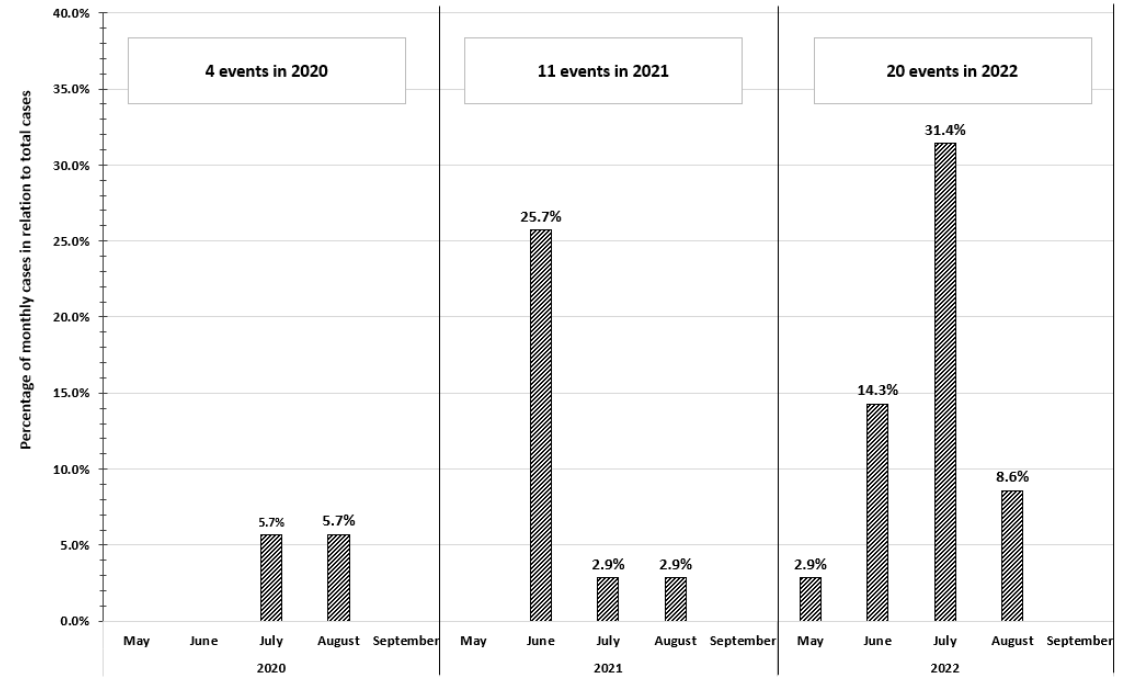
Figure 1. Distribution of events reported by Italian online newspapers in the years 2020 to 2022, by month and year of publication. Table 3. Demographic characteristics (gender, age and nationality) as reported by Italian online newspapers in the years 2020 to 2022, by age